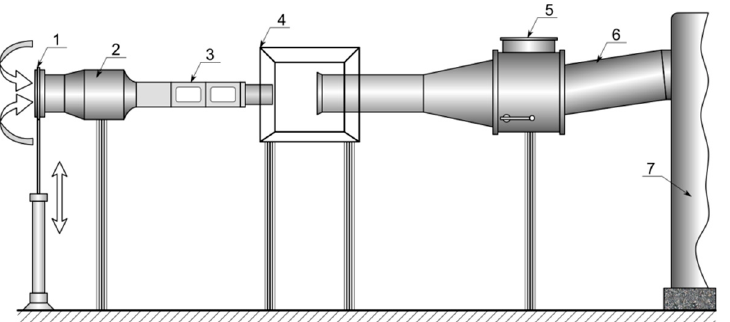
Figure 1. General view of the experimental setup: 1—pneumatic valve; 2—receiver; 3—working chamber with the supersonic insert and water supply to the stream; 4—vacuum chamber, 5—vacuum seal, 6–gas flow path, 7—gas tanks.